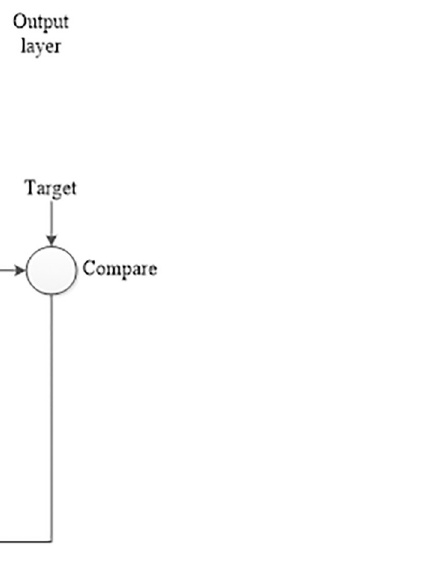
Fig 2. Basic artificial neural network